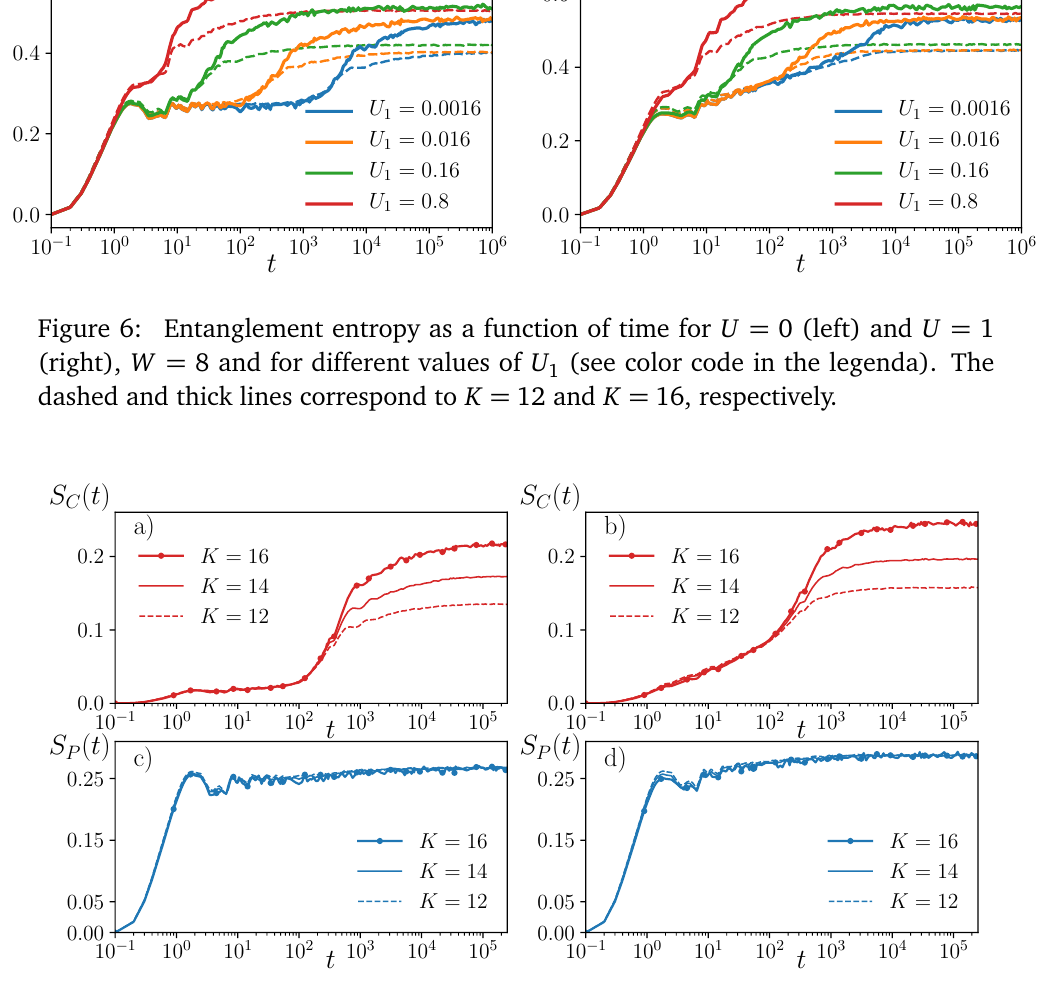
( t ) [ top row, panels a) and b) ] and Figure 7: Configuration entanglement entropy S C ( t ) [ bottom row, panels c) and d) ] as a function of time in the the particle entropy S P = 0.016 corresponding localized regime ( W = 10) of the model with U = 0 and U 1 to the Anderson case perturbed by the long-range interactions [ left column, panels a) and c) ] . The plots in the right column [ panels b) and d) ] with U = 1 correspond to long-range interaction perturbation of the MBL case. The effect of small U in 1 both cases is quite similar. Thick, dashed and thin lines correspond to K = 16,14 and K = 12